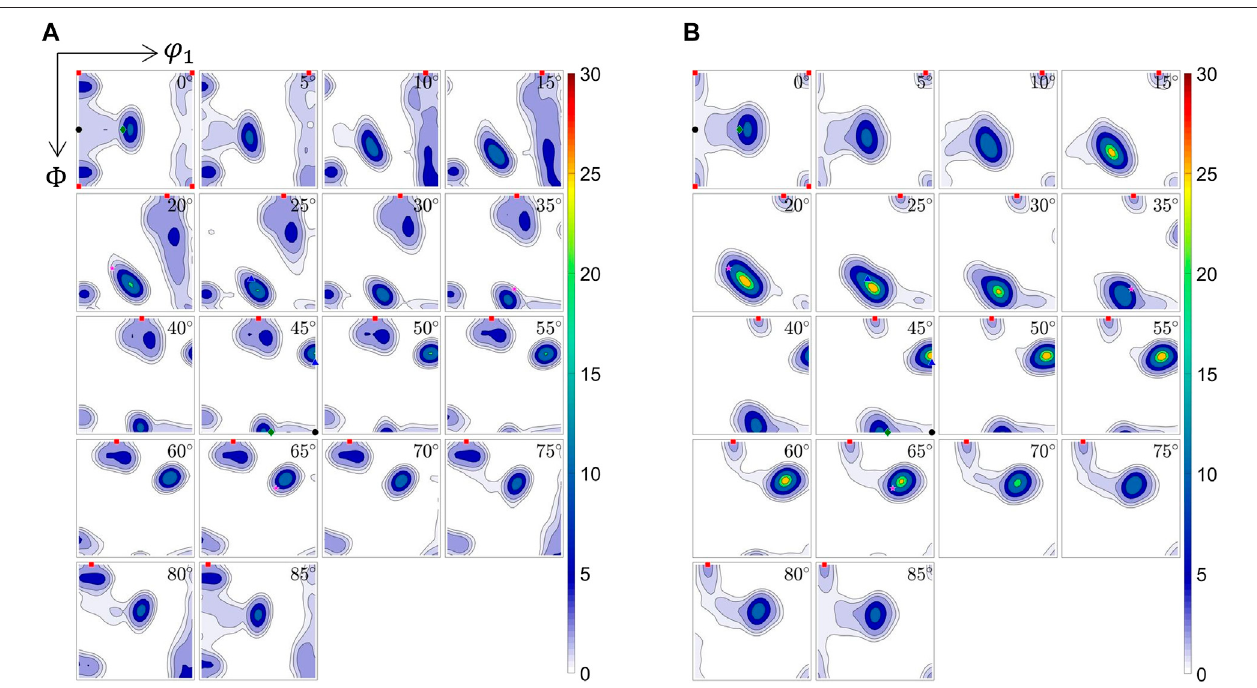
FIGURE 4 | Texture predictions computed by (A) FC-Taylor and (B) Alamel models with parameters giving the best match with the experimentally measured texture for AA6063, T 350 ° C.